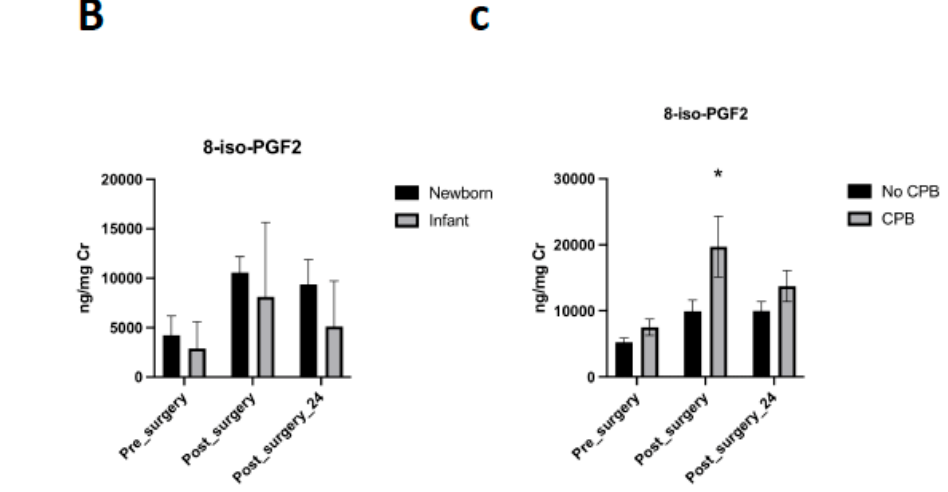
Figure 2. Levels of 8-iso-PGF2 α . ( A ) Evolution of 8-iso-PGF2 α in the perioperative period. ( B ) Levels of 8-iso-PGF2 α in the perioperative period considering age group. ( C ) Evolution of 8-iso-PGF2 α in the perioperative period considering the requirement of cardio-pulmonary bypass (CPB) during the surgery. (* p = 0.0214)